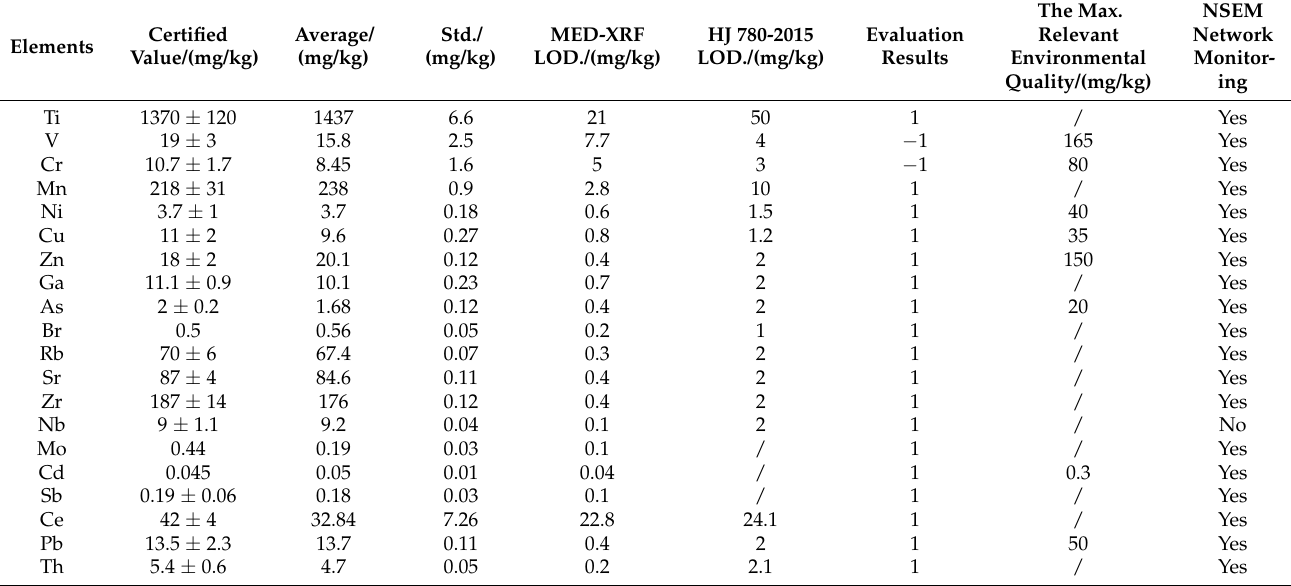
Table 1. The limit of detection of